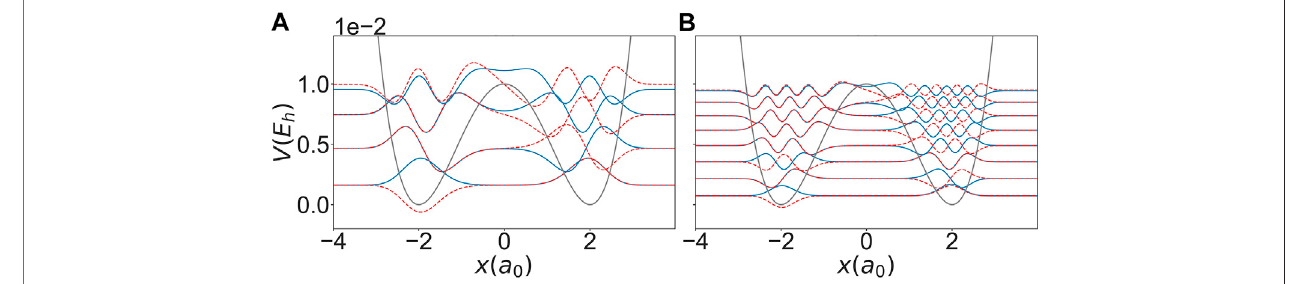
FIGURE 1 | Eigenstates for a particle of mass (A) 1 m H and (B) 5 m H in the potential given by Eq. 21 with x B (cid:1) 2 a 0 and V B (cid:1) 0 . 01 E h . Solid and dashed lines correspond to even and odd eigenstates, respectively.